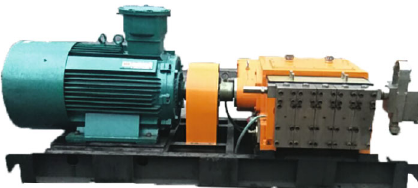
Figure 12: Schematic diagram of ultra-high-pressure hose.